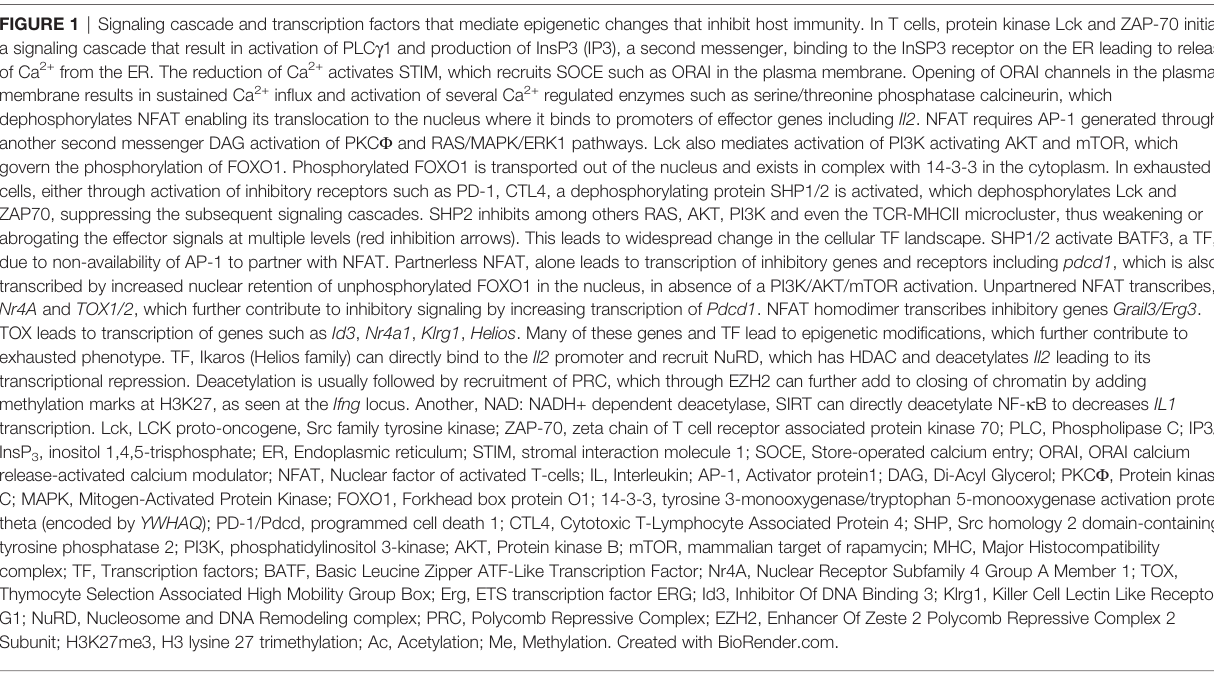
FIGURE 1 | Signaling cascade and transcription factors that mediate epigenetic changes that inhibit host immunity. In T cells, protein kinase Lck and ZAP-70 initiate a signaling cascade that result in activation of PLC g 1 and production of InsP3 (IP3), a second messenger, binding to the InSP3 receptor on the ER leading to release of Ca 2+ from the ER. The reduction of Ca 2+ activates STIM, which recruits SOCE such as ORAI in the plasma membrane. Opening of ORAI channels in the plasma membrane results in sustained Ca 2+ in fl ux and activation of several Ca 2+ regulated enzymes such as serine/threonine phosphatase calcineurin, which dephosphorylates NFAT enabling its translocation to the nucleus where it binds to promoters of effector genes including Il2 . NFAT requires AP-1 generated through another second messenger DAG activation of PKC F and RAS/MAPK/ERK1 pathways. Lck also mediates activation of PI3K activating AKT and mTOR, which govern the phosphorylation of FOXO1. Phosphorylated FOXO1 is transported out of the nucleus and exists in complex with 14-3-3 in the cytoplasm. In exhausted T cells, either through activation of inhibitory receptors such as PD-1, CTL4, a dephosphorylating protein SHP1/2 is activated, which dephosphorylates Lck and ZAP70, suppressing the subsequent signaling cascades. SHP2 inhibits among others RAS, AKT, PI3K and even the TCR-MHCII microcluster, thus weakening or abrogating the effector signals at multiple levels (red inhibition arrows). This leads to widespread change in the cellular TF landscape. SHP1/2 activate BATF3, a TF, due to non-availability of AP-1 to partner with NFAT. Partnerless NFAT, alone leads to transcription of inhibitory genes and receptors including pdcd1 , which is also transcribed by increased nuclear retention of unphosphorylated FOXO1 in the nucleus, in absence of a PI3K/AKT/mTOR activation. Unpartnered NFAT transcribes, Nr4A and TOX1/2 , which further contribute to inhibitory signaling by increasing transcription of Pdcd1 . NFAT homodimer transcribes inhibitory genes Grail3/Erg3 . TOX leads to transcription of genes such as Id3 , Nr4a1 , Klrg1 , Helios . Many of these genes and TF lead to epigenetic modi fi cations, which further contribute to exhausted phenotype. TF, Ikaros (Helios family) can directly bind to the Il2 promoter and recruit NuRD, which has HDAC and deacetylates Il2 leading to its transcriptional repression. Deacetylation is usually followed by recruitment of PRC, which through EZH2 can further add to closing of chromatin by adding methylation marks at H3K27, as seen at the Ifng locus. Another, NAD: NADH+ dependent deacetylase, SIRT can directly deacetylate NF- k B to decreases IL1 transcription. Lck, LCK proto-oncogene, Src family tyrosine kinase; ZAP-70, zeta chain of T cell receptor associated protein kinase 70; PLC, Phospholipase C; IP3/ InsP 3 , inositol 1,4,5-trisphosphate; ER, Endoplasmic reticulum; STIM, stromal interaction molecule 1; SOCE, Store-operated calcium entry; ORAI, ORAI calcium release-activated calcium modulator; NFAT, Nuclear factor of activated T-cells; IL, Interleukin; AP-1, Activator protein1; DAG, Di-Acyl Glycerol; PKC F , Protein